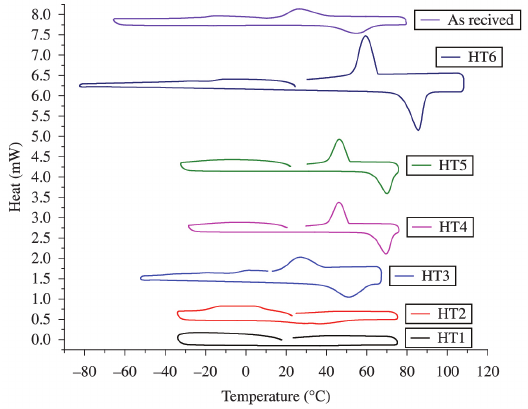
Figure 2. DSC peaks obtained from the states of the Ti-Ni-Cu samples.